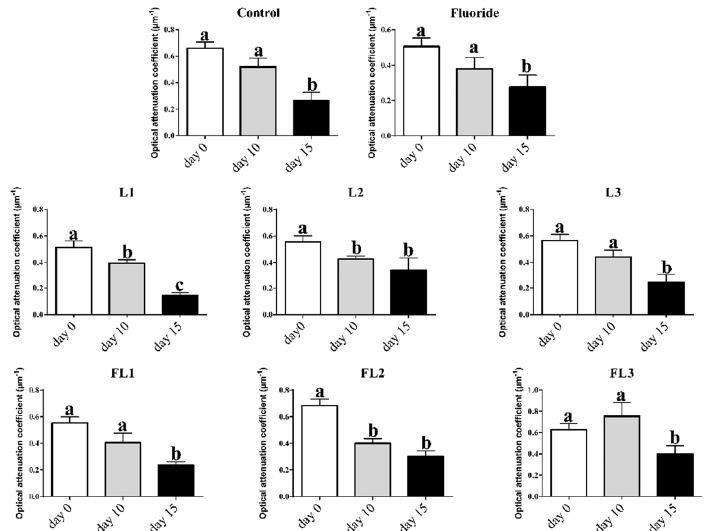
Figure 2. Averaged values of optical attenuation coefficient calculated from OCT images that were collected before the erosion cycle (day 0), immediately after receiving treatment (day 10) and at the end of demineralization challenge (day 15). Bars denote standard error. Distinct letters indicate statistically significant differences (p < 0.05), according to Tukey’s